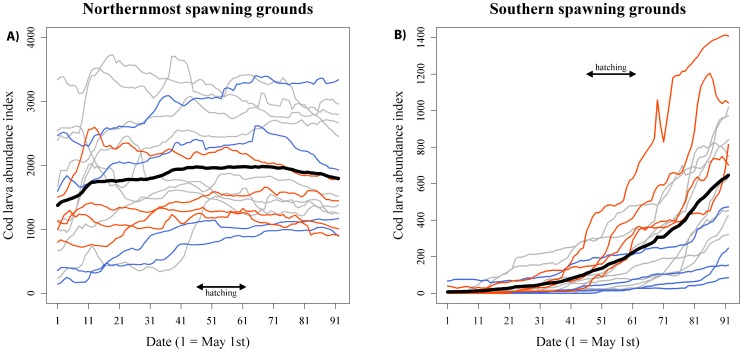
Arrival time of cod larvae to Hornøya.Accumulation of cod larvae from northern (A) and southern (B) spawning grounds around Hornøya during the breeding season of common guillemots in different years. Red lines mark the upper quartiles (4 years) of chick body size and blue lines the lower quartiles (4 years). Grey lines show the remaining eight years. The mean for all years is indicated by a bold line and the spread in guillemot hatching dates is indicated (unpubl. data). Note that the scaling on the y-axis differs in the two graphs.